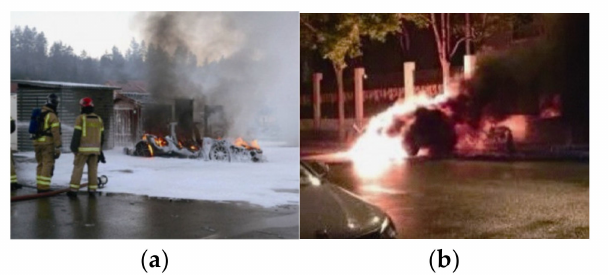
Figure 1. Lithium ion battery failure accident of electric vehicle [1]. ( a ) Battery catches fire when charging; ( b ) Self-ignition of the